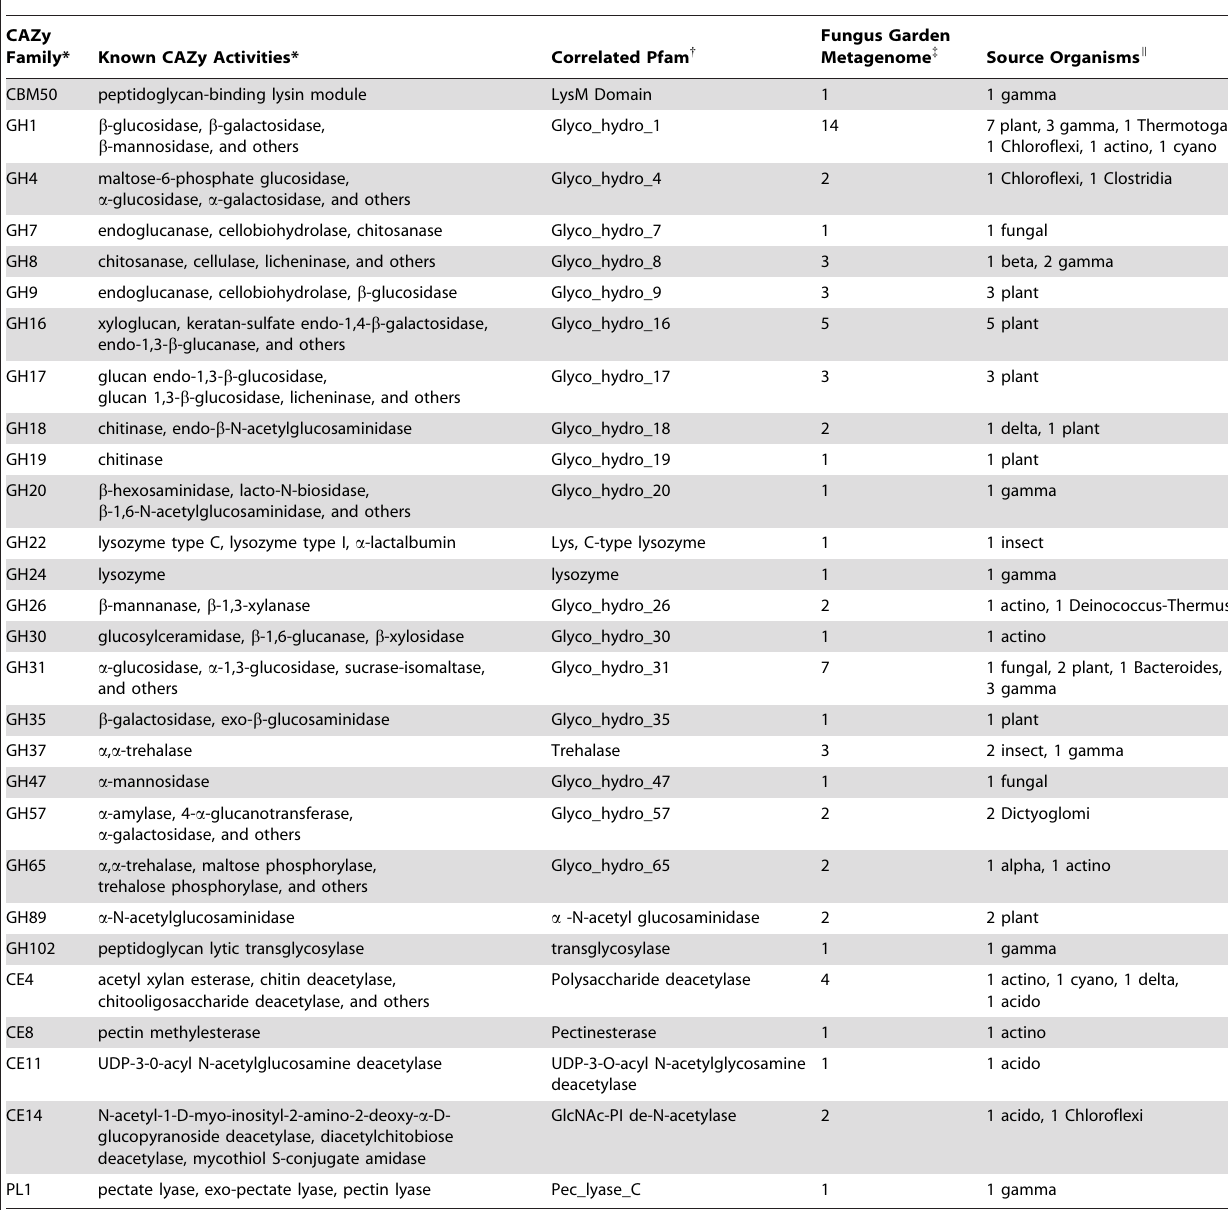
Table 2. Carbohydrate-active enzymes in the leaf-cutter ant fungus garden community metagenome.